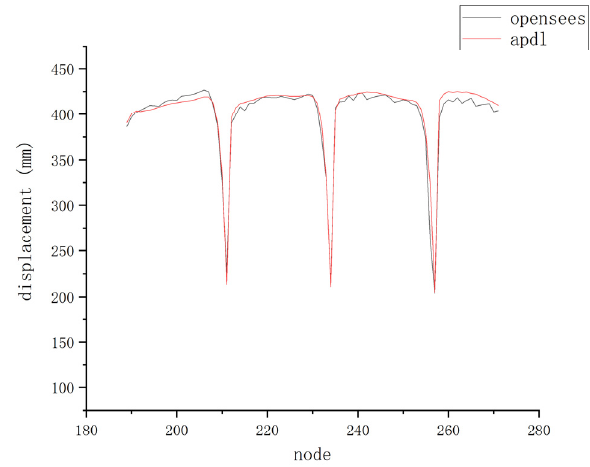
Figure 9. Comparison diagram of node displacement.